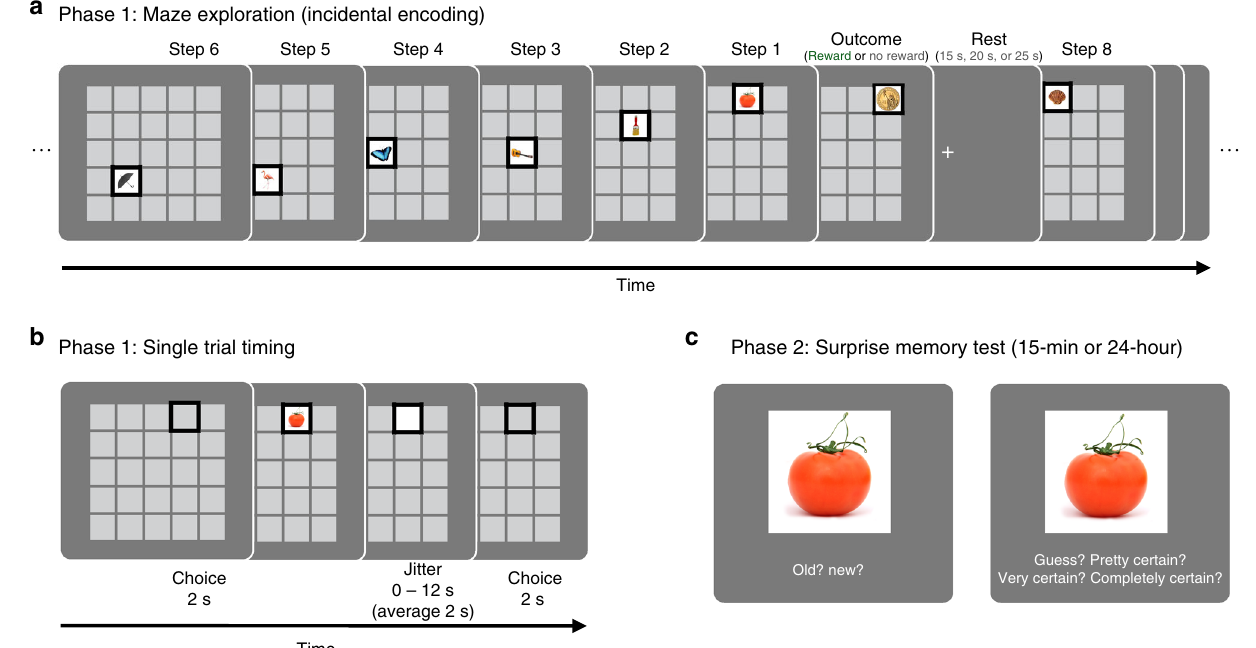
Fig. 1 Experimental design to test the retroactive effect of reward on memory. The task consisted of maze exploration followed by a surprise memory test. a In the maze exploration phase, participants explored a series of mazes searching for a gold coin (each worth a bonus $1; 2007 Presidential $1 Coin image from the United States Mint). Mazes varied in length, ranging from 3 to 15 steps. Participants explored a total of 22 mazes. Half of the mazes ended